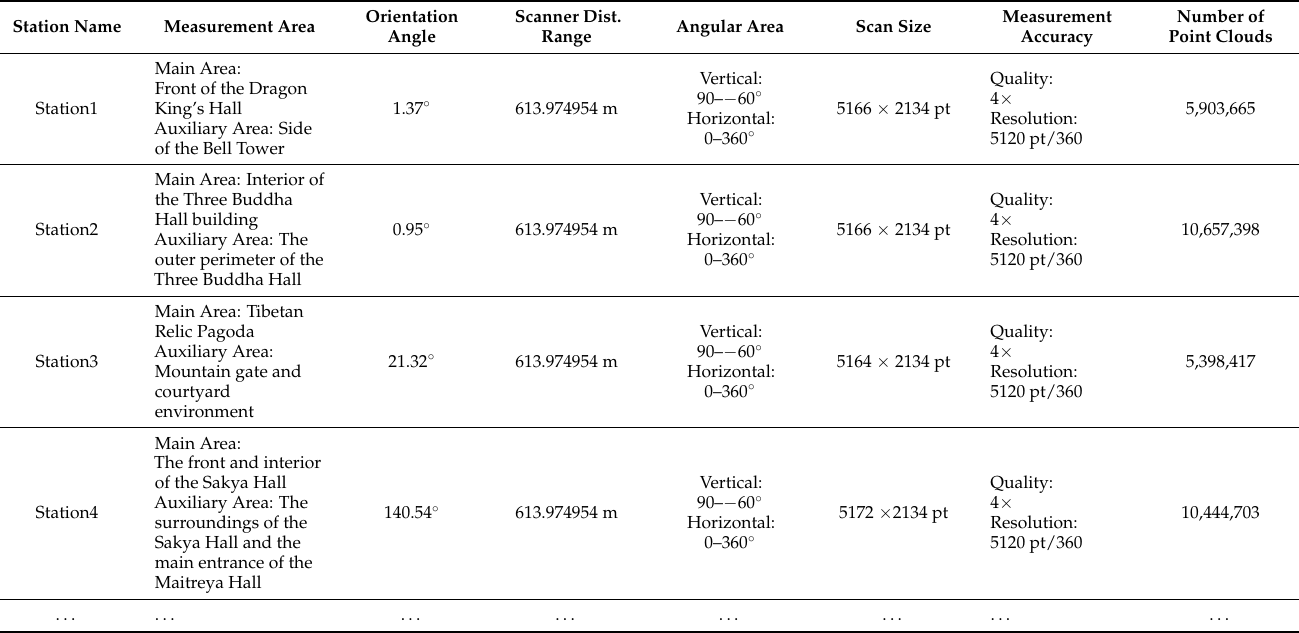
Table 1. Scanning data information